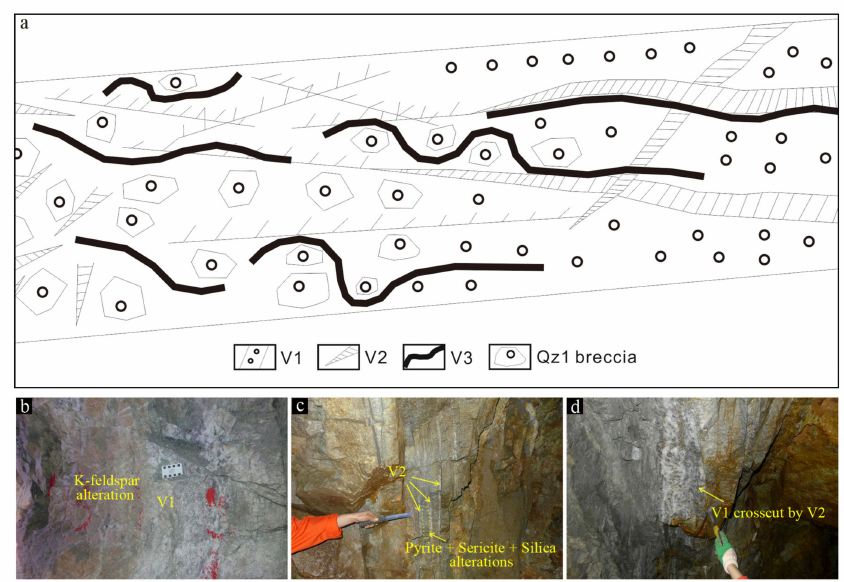
Figure 3. A sketch of vein types and their crosscutting relationship ( a ) and underground-tunnel images of the vein generations of the Linglong goldfield. ( b ) Cracked V1 developed with K-feldspar alterations.